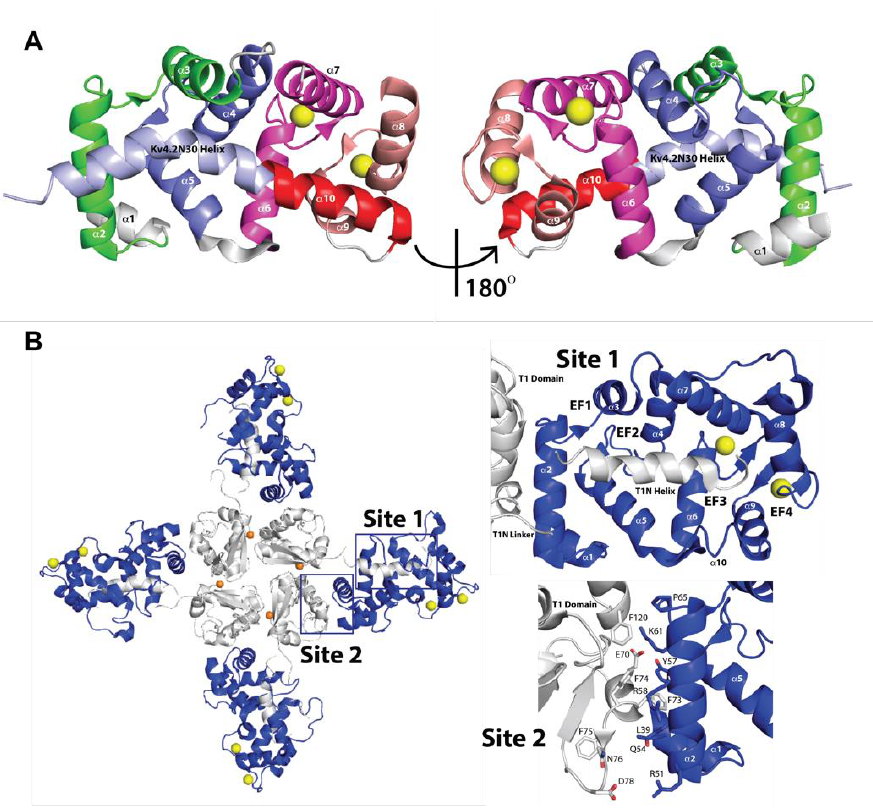
Figure 4. Three-dimensional structures of KChIPs–K V 4 complexes. ( A ) KChIP1(34–216)–K V 4.2N30 complex structure (PDB ID 1S6C) showing the four EF-hand motifs (helices H2–H9) and the central hydrophobic pocket occupied by H10 (red) and K V 4.2N30 (light blue) helices [53]. (B ) Left panel: Overall structure of the KChIP1–K V 4.3 T1 complex as seen from the cytosolic side (PDB ID 2I2R) [55]. KChIP1s are shown in dark blue and K V 4.3 members are shown in white. Ca 2+ ions are shown as yellow spheres and Zn 2+ ions are shown in orange. Boxes represent interaction site 1 and interaction site 2. Top right panel: Interaction site 1 showing KChIP1 in dark blue and K V 4.3 T1N helix, T1N linker, and T1 domain in white. Ca 2+ ions are shown as yellow spheres. Bottom right panel : Interaction site 2 showing the main interface KChIP1(34–216)-K V 4.2N30 residues. KChIP1 in dark blue and K V 4.2N30 residues in white.